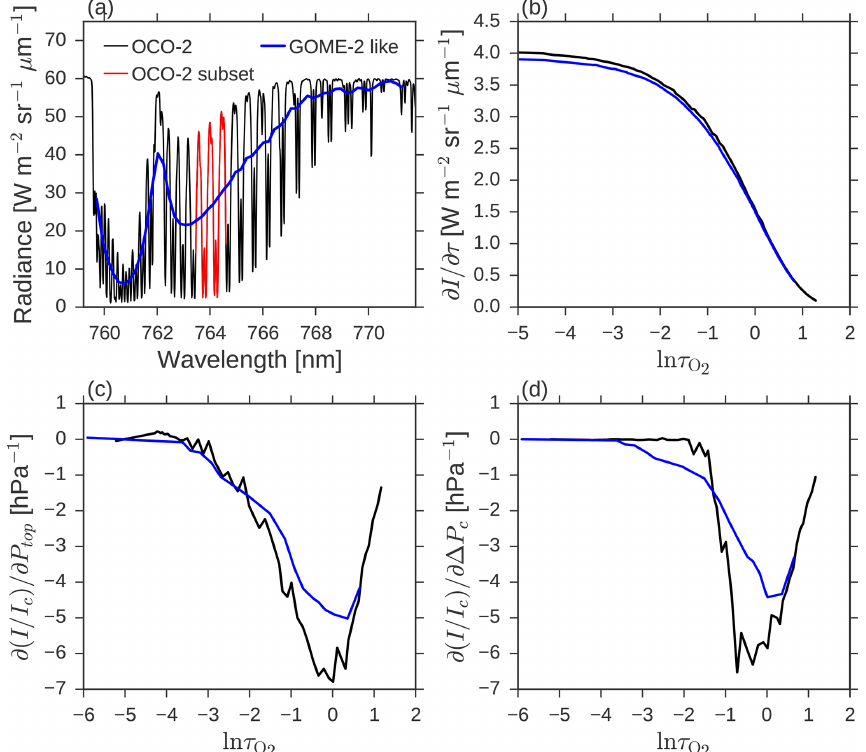
Figure 1. (a) Simulated A-band reflectance spectrum for a vertically homogeneous cloud with τ = 10, r e , h = 12µm and P top = 750hPa as seen by OCO-2 and GOME-2-like sampling. The red OCO-2 subset refers to the 75 channels used in OCO2CLD-LIDAR-AUX. (b) OCO- 2 and GOME-2 cloud τ Jacobians with channels organized by the baseline spectrum’s channel mean molecular oxygen ln (τ O Jacobians in response to P top . (d) I/I c Jacobians in response to (cid:49)P c